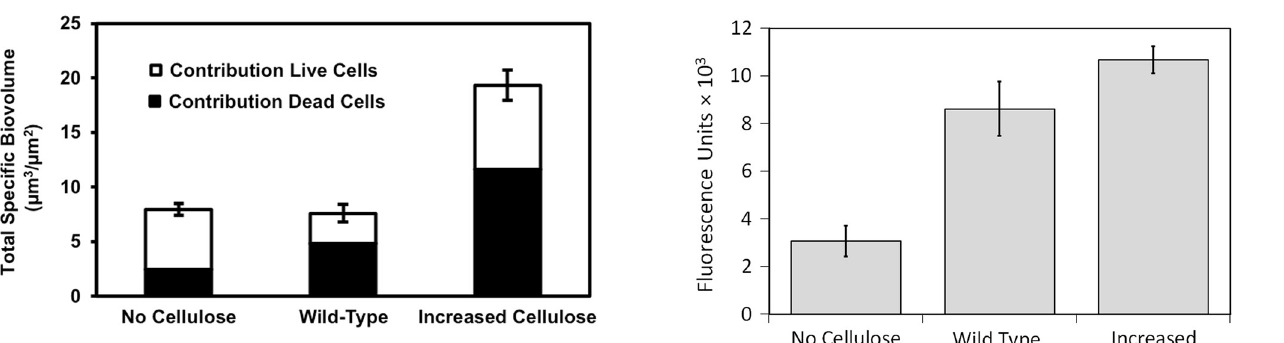
Fig. 2 Total speci fi c biovolumes of the bio fi lms formed by cellulose variants of V. fi scheri . Each bar is a stacked total of the individual biovolume contributions from live and dead cells, identi fi ed using SYTO-9 and PI stains, respectively. Error bars represent 1 standard error